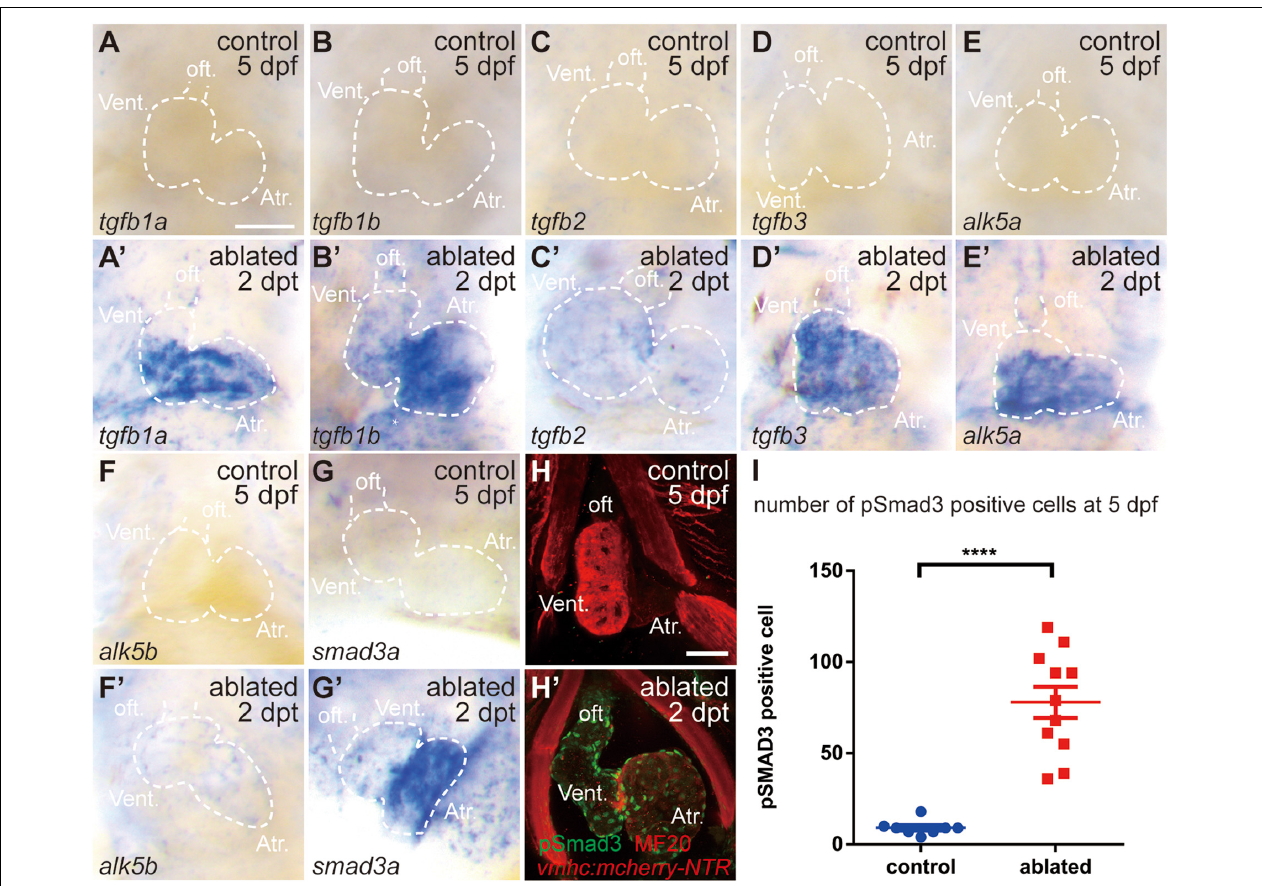
FIGURE 1 | TGF- β /Smad3 signaling is activated during zebrafish ventricular regeneration. (A–G (cid:48) ) Whole-mount in situ hybridization showing that the expression of components of the TGF- β signaling pathway, tgfb1a , tgfb1b , tgfb2 , tgfb3 , alk5a , alk5b , and smad3a , was upregulated in the ablated hearts (A (cid:48) –G (cid:48) ) compared with that in the control hearts (A–G) at 5 dpf/2 dpt. Dashed lines outline the hearts. (H–H (cid:48) ) Representative immunostaining images of Tg(vmhc:mCherry-NTR) hearts showing that phospho-Smad3 signal was increased in the ablated hearts (H (cid:48) ) than in the control hearts (H) at 5 dpf/2 dpt. Green, anti-pSmad3; red, MF20 (anti-MHC). (I) Quantification of phospho-Smad3-positive cells in the control and ablated hearts at 5 dpf/2 dpt ( N = 8 and 11, respectively). Mean ± s.e.m., Student’s t -test, two-tailed, **** P < 0.0001. Scale bars, 50 µ m. dpf, days post-fertilization; dpt, days post-treatment; atr., atrium; oft., out flow tract; vent.,